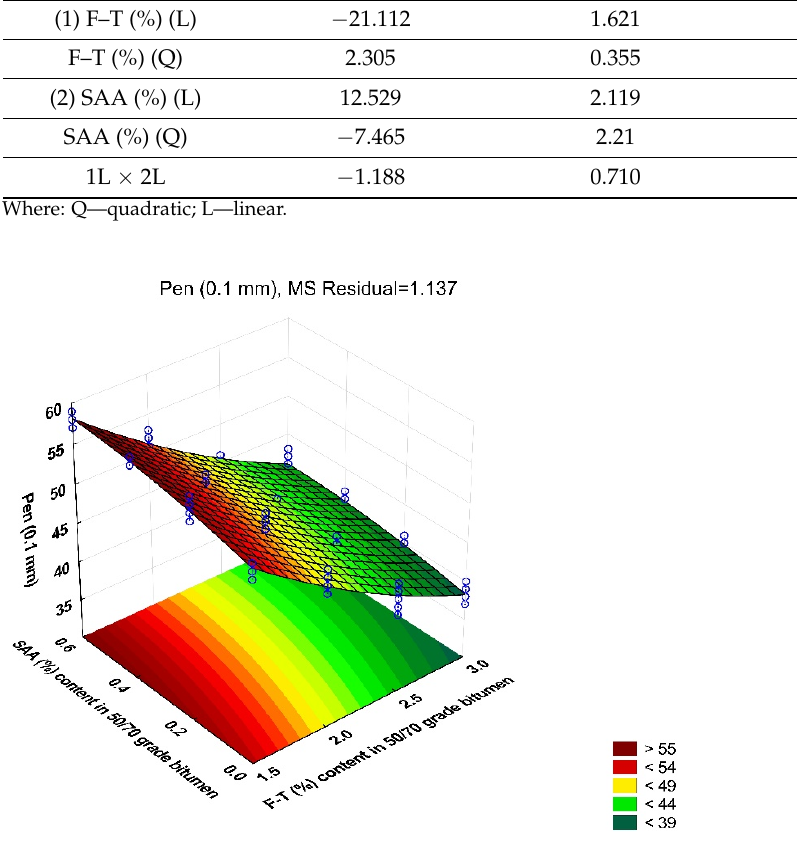
Figure 5. Response surface plot for bitumen 50/70 variability and its model. ∙ ∙